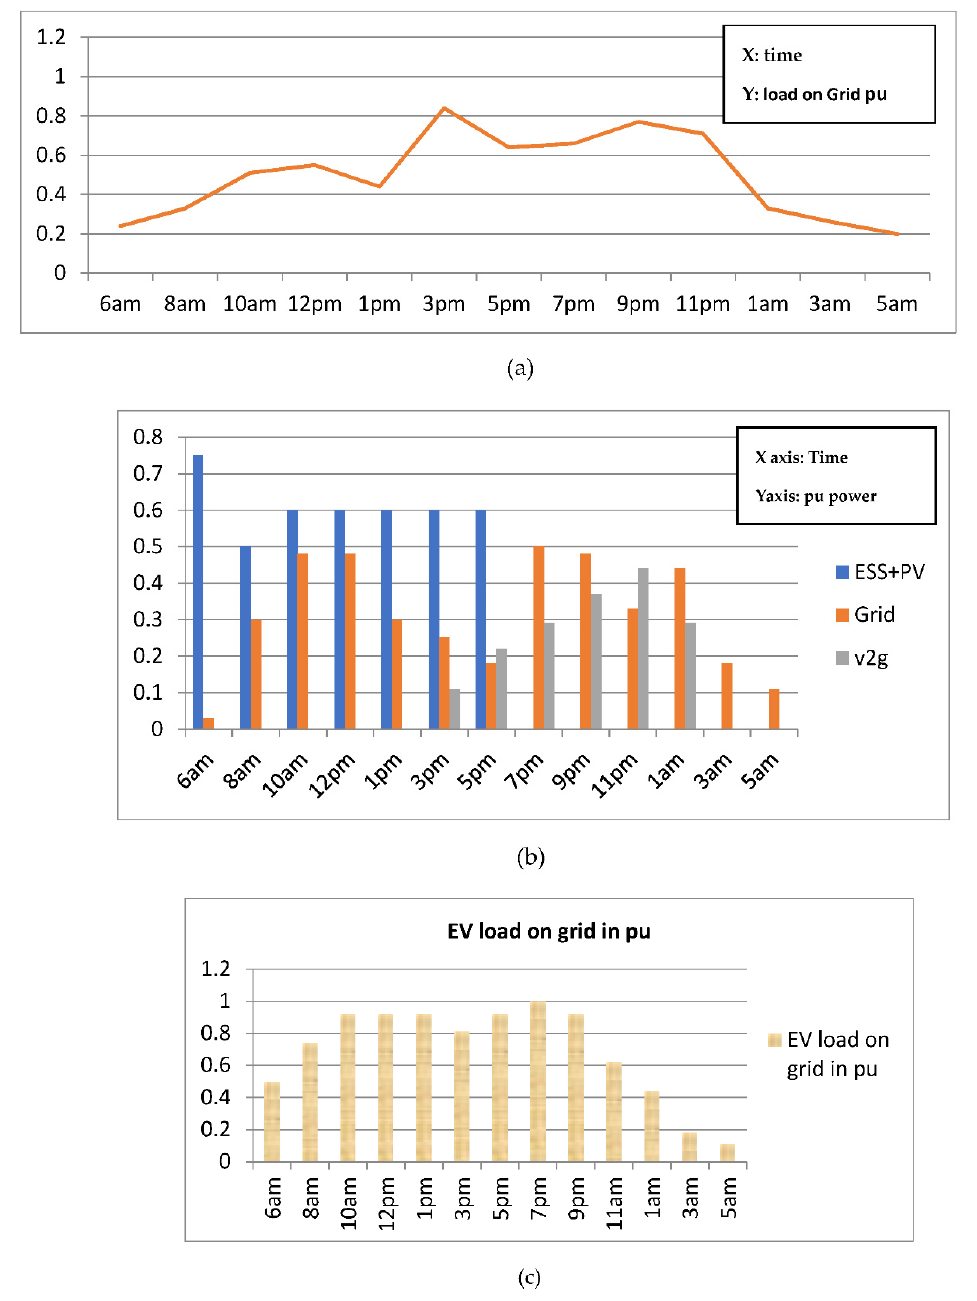
Figure 3. ( a ) Daytime on-grid energy demand. ( b ) EV load distribution by sources and charging allocation priority. ( c ) EV power demand at the charging station.